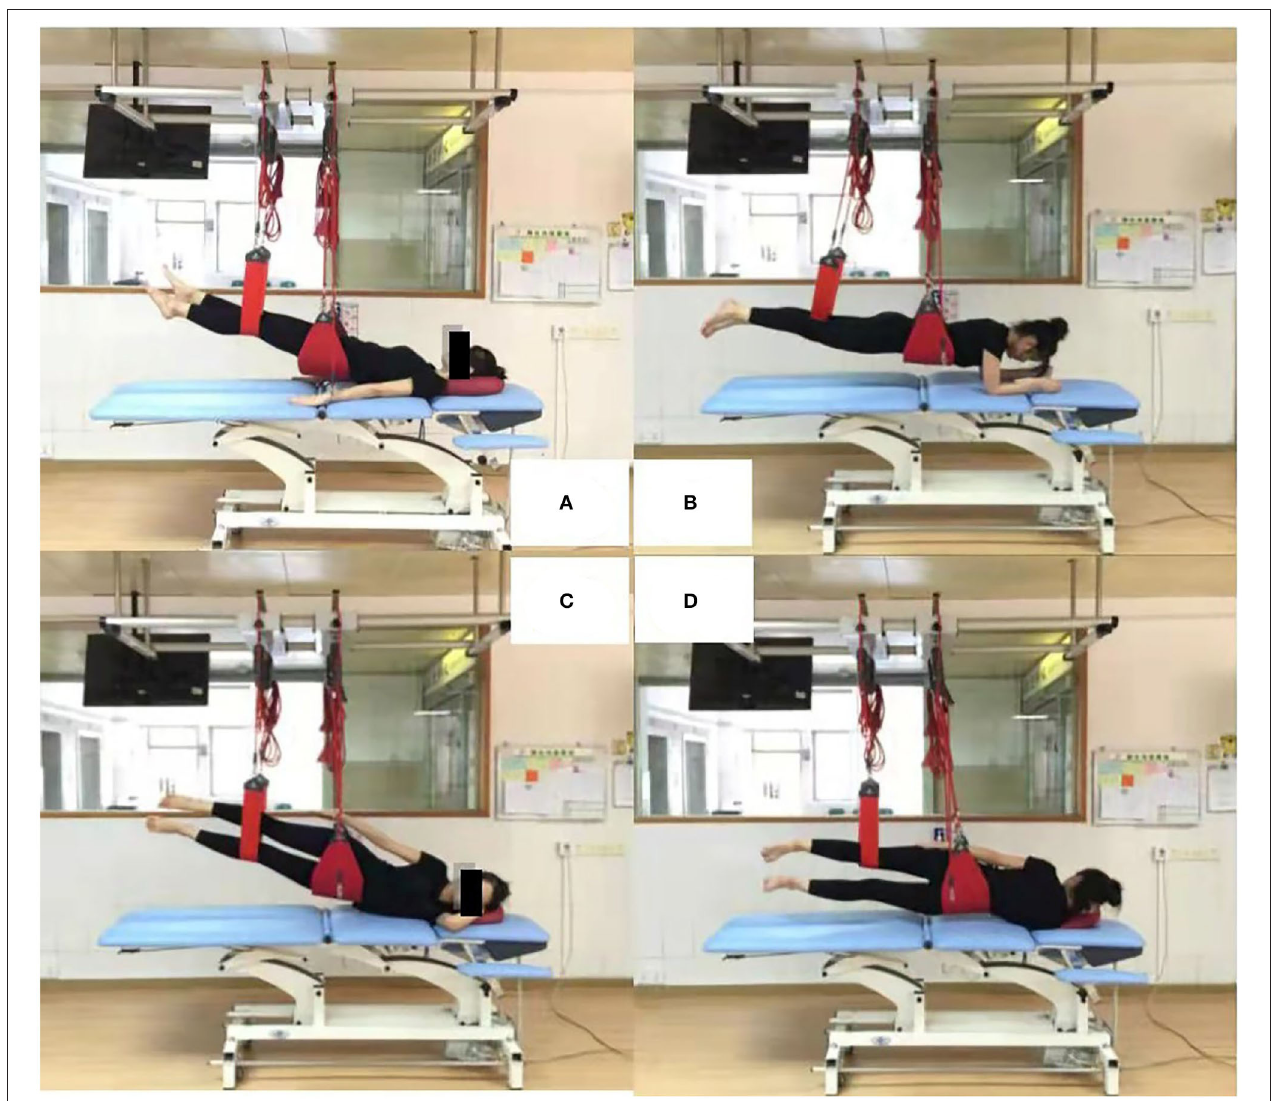
FIGURE 2 | Four sling exercises. (A) : supine pelvic lift (SPL); (B) : prone bridging (PB); (C) : side-lying hip abduction (SLAb); (D) : side-lying hip adduction (SLAd).